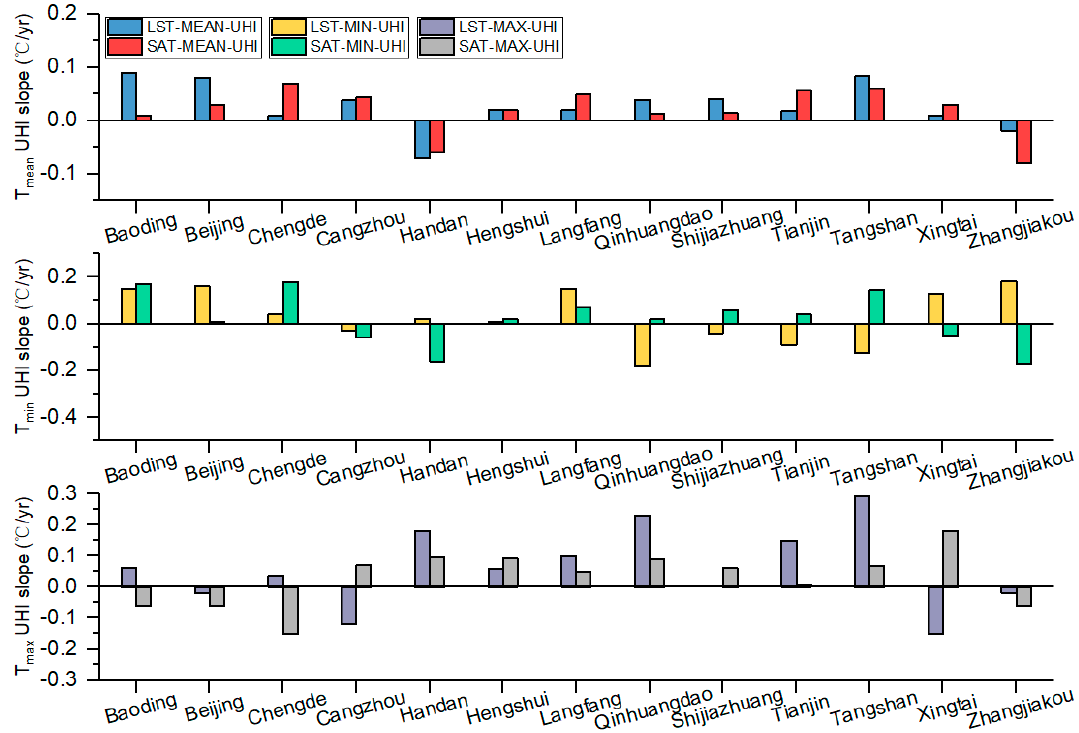
Figure 5. The trends of UHI slopes derived from LST and SAT.